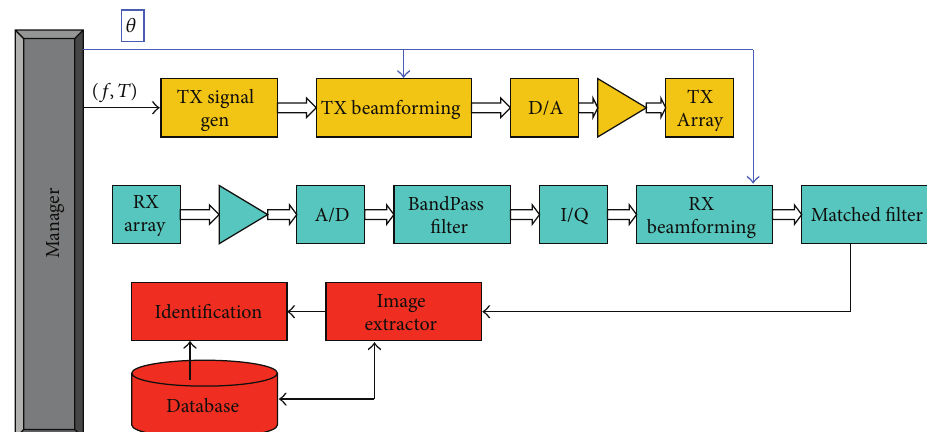
Figure 1: Functional description block